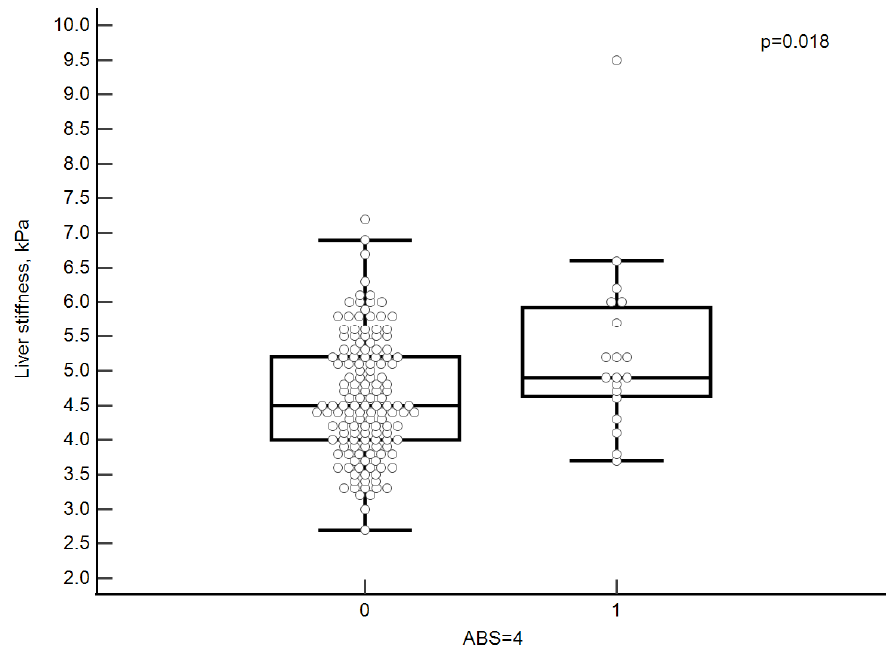
Figure 4. Liver stiffness values in patients with generalized atherosclerosis (ABS = 4). Each point represents a single case. The lines in the figure represent (from inside to outside): median, upper and lower quartile, minimum and maximum.